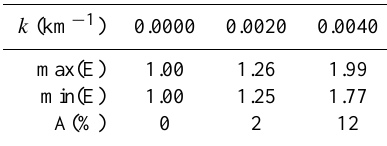
Table 1. Enhancement parameter and anisotropy parameter in the example case.